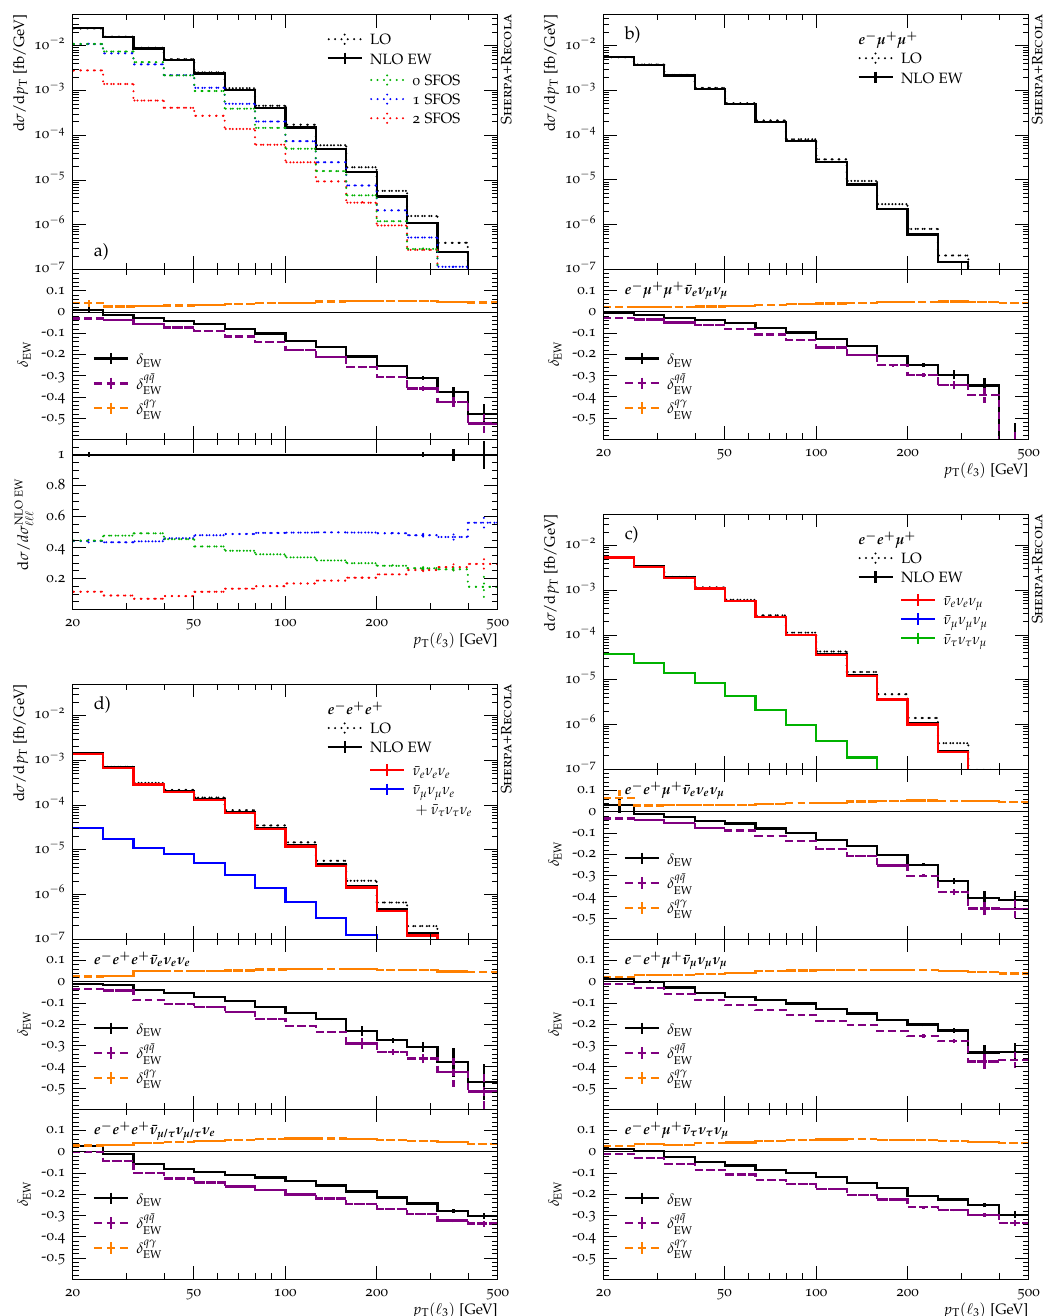
Figure 5 . Electroweak corrections to the third-leading lepton transverse momentum distribution.